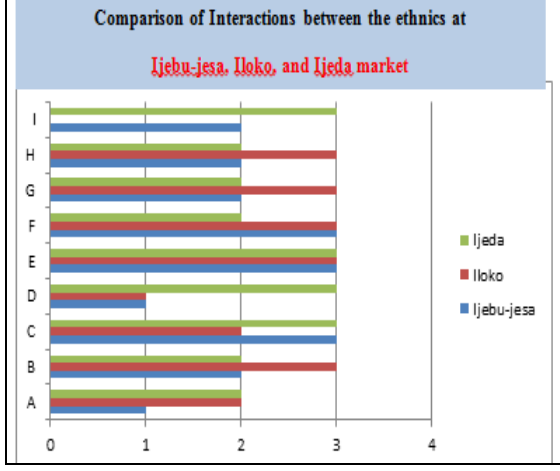
Figure 8. Comparison of residents’ interaction and duration in the three-neighbourhood market place. A =Hausa & Igbo, B =Hausa & Yoruba, C =Hausa & Hausa, D =Yoruba & Igbo, . E =Yoruba & Hausa, F =Yoruba & Yoruba, G =Igbo & Hausa, H =Igbo & Yoruba, I =Igbo & Igbo. ×1= Less than 15 minutes (short interaction), ×2= between 15 to 20 minutes